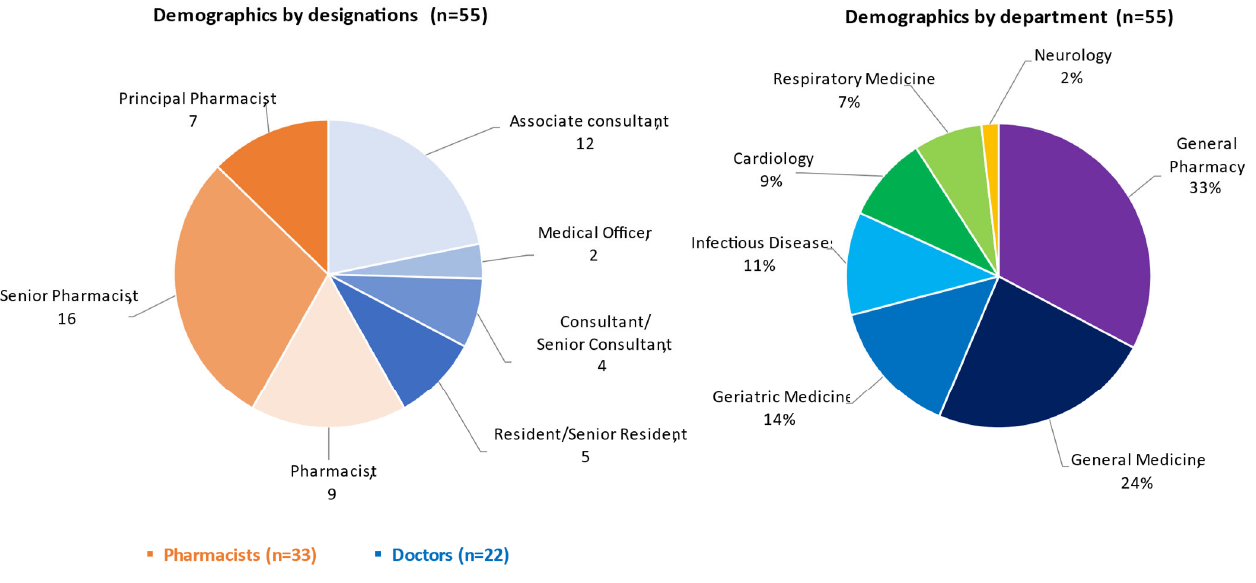
Figure 1. Demographics of survey respondents ( n = 55) .